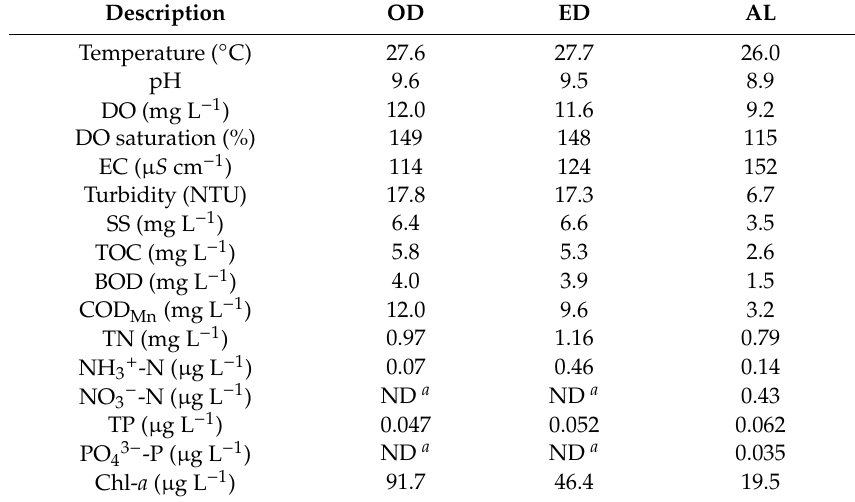
Table 2. Measures of water quality from the three water samples collected at di ff erent sampling